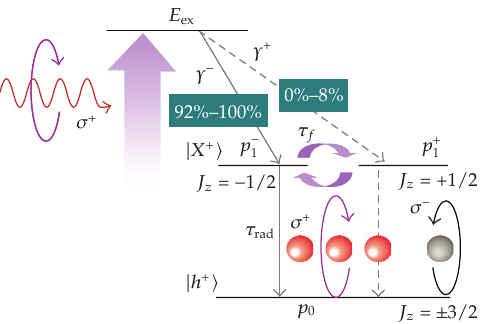
Figure 7: Schematic summary of the conversion process from incident coherent light (cid:5) wavy arrow (cid:6) to electron spins and further conversion to the single photon output. Polarization of photon is well preserved in the generated positive trion spins under the quasi-resonant excitation. The spin flip between the trion states with the opposite spin alignments will limit the spin preservation, but this influence is much reduced in the present trion state. The estimated fidelity, corresponding to the DCP of 0.85, is as high as